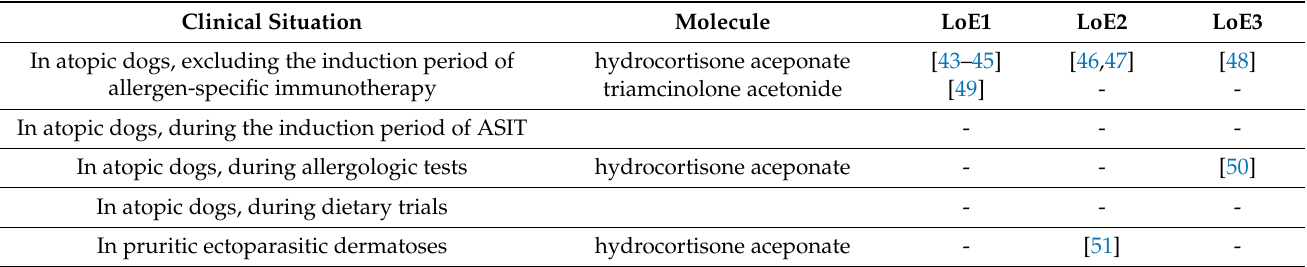
Table 3. Level of evidence (LoE) in individual studies of the use of topical glucocorticoids in different clinical